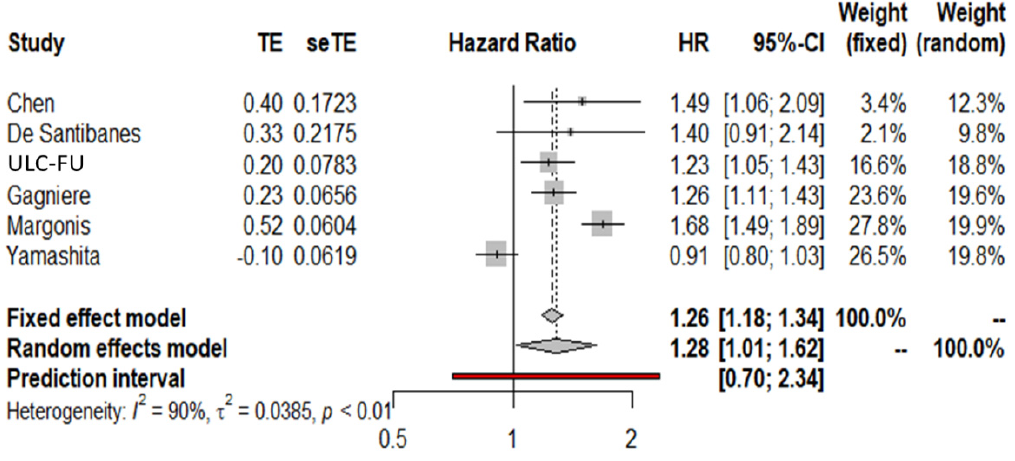
Figure 5. Forest plot for KRAS sidedness interaction terms (left does not include rectal tumors).